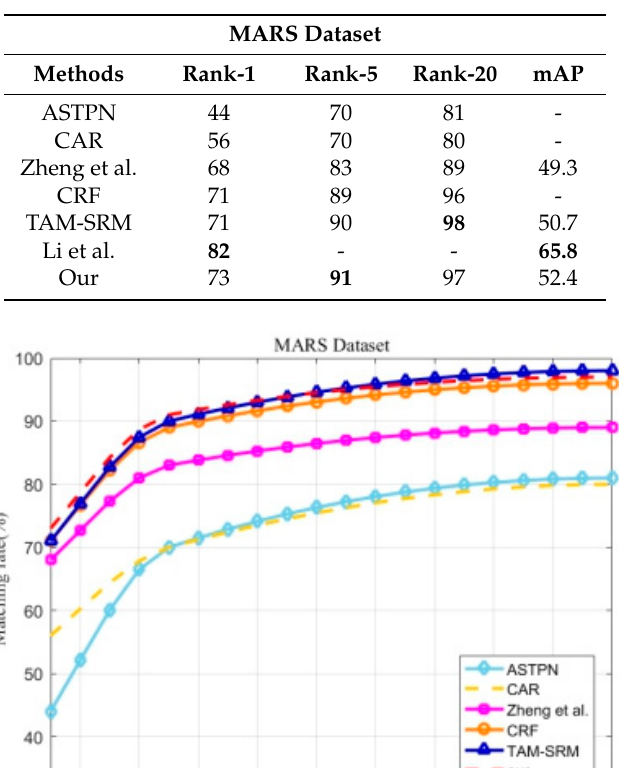
Table 5. Comparison experiment with other state-of-the-art algorithms on the MARS dataset in terms of CMC values and mean average precision (mAP).